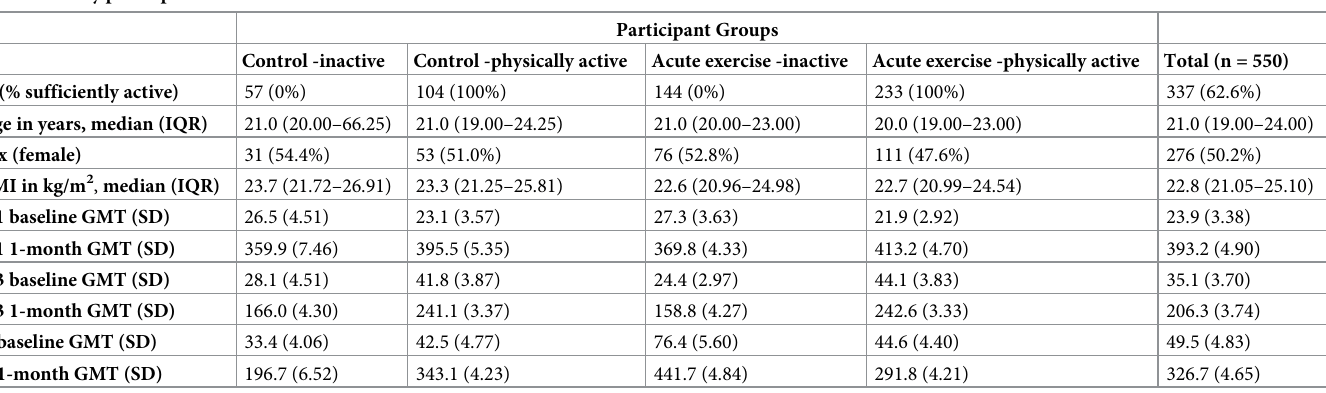
Table 2. Study participants’